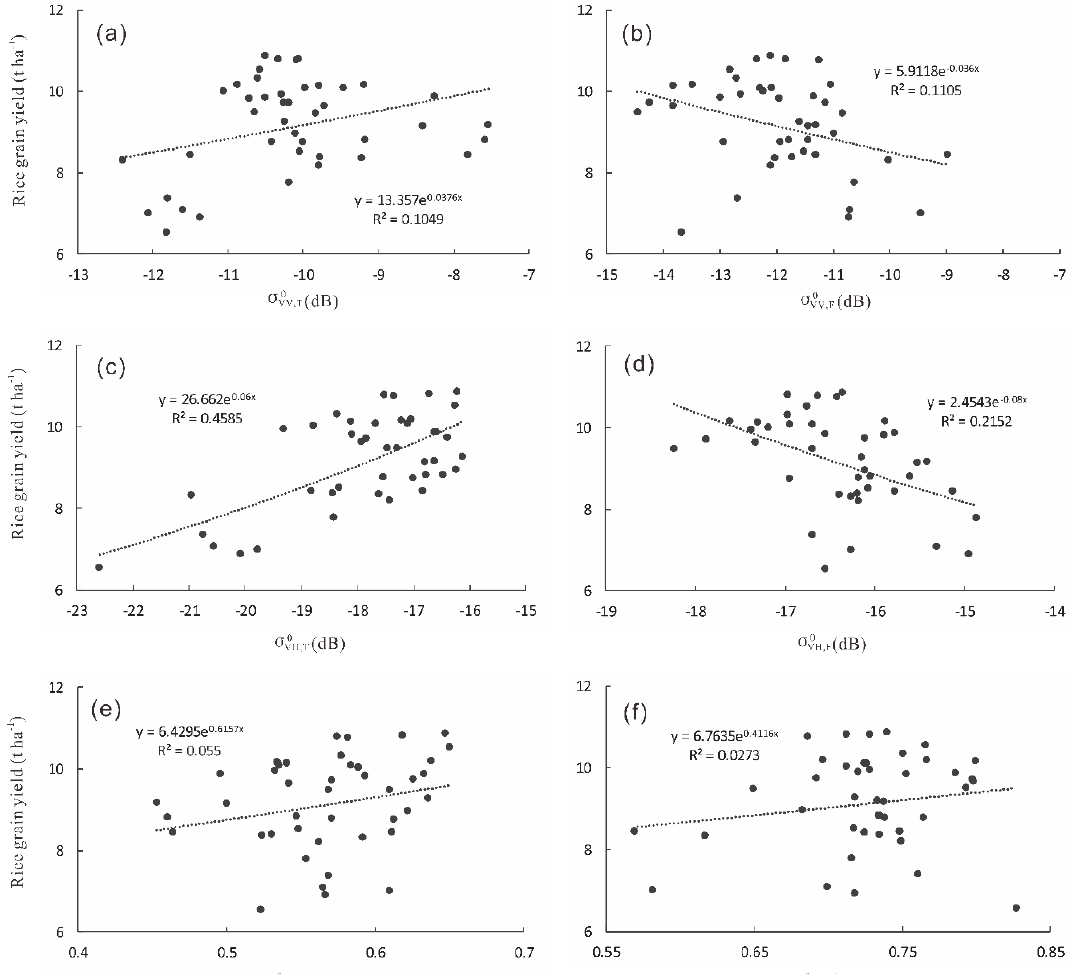
Figure 3. Scatter plots of SAR indices at single growth stage (x-axis) and grain yield (y-axis). ( a ), ( c ) & ( e ) tillering stage, ( b ), ( d ) & ( f ) grain filling stage.